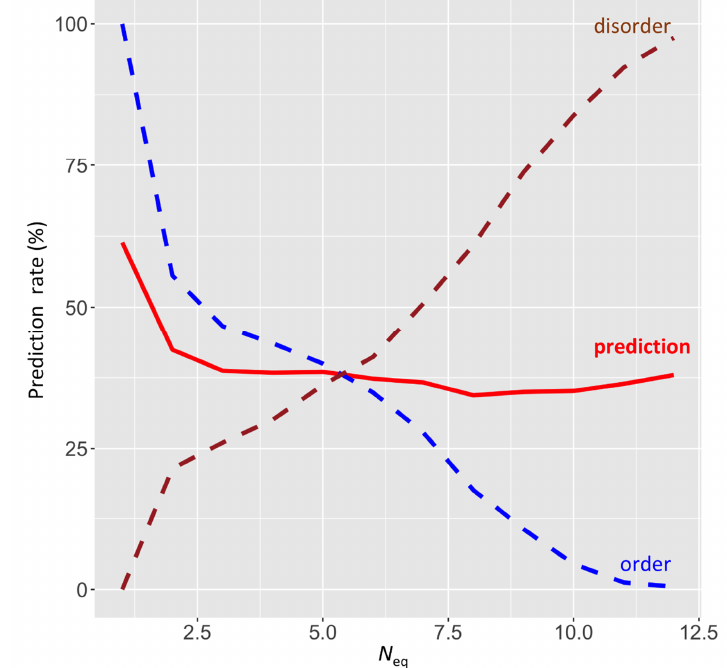
Figure 4 Figure 4. Evaluation of Disopred3 predictions at the light of N eq values. N eq values ranging from 1.0 to 12 are provided with the prediction rate (in red). The contribution of disordered and ordered positions are defined by the N eq